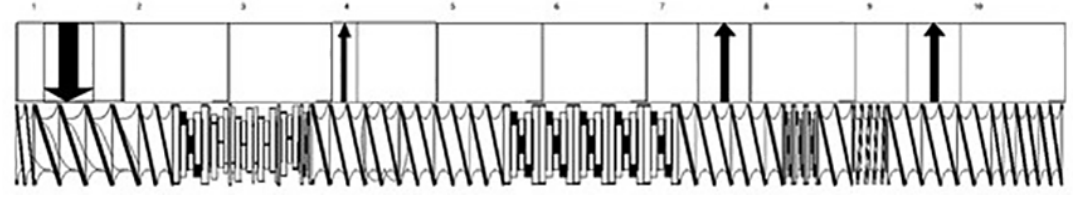
Figure 1. Extruder screw profile.